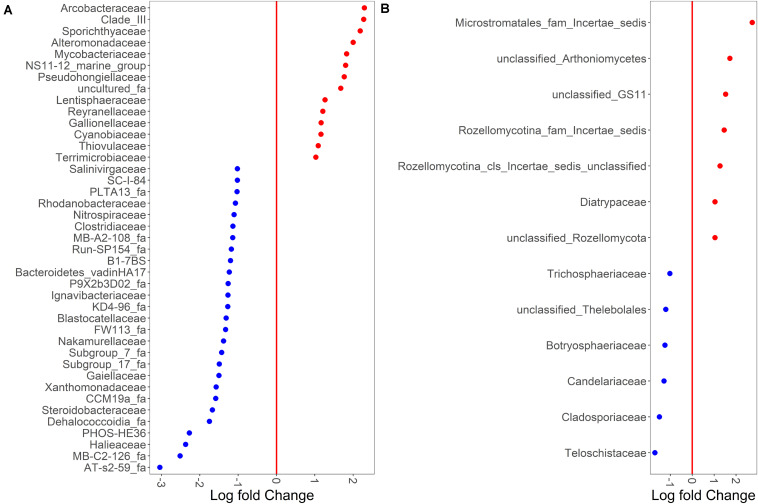
Binomial differential abundance of microbial families between (A) bacterial and (B) fungal communities of surface water samples.